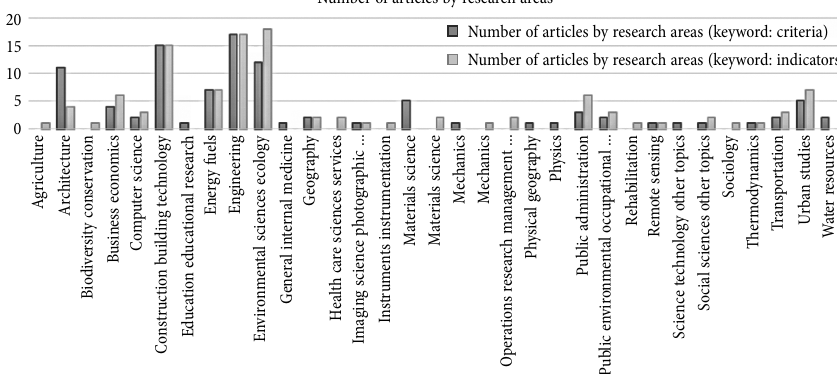
Fig. 4. Review of articles on criteria and indicators of the sustainable built environment by a research area